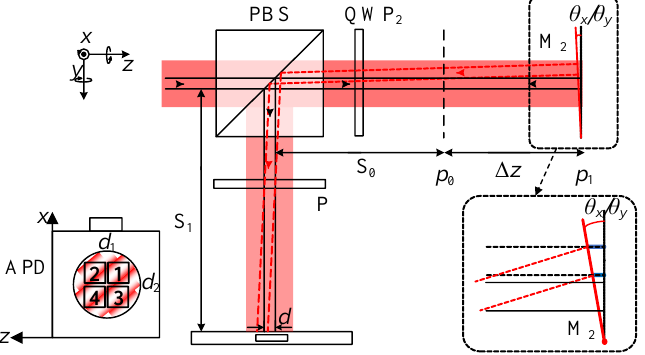
Figure 2. Schematic diagram of OPD change caused by rotation angle.